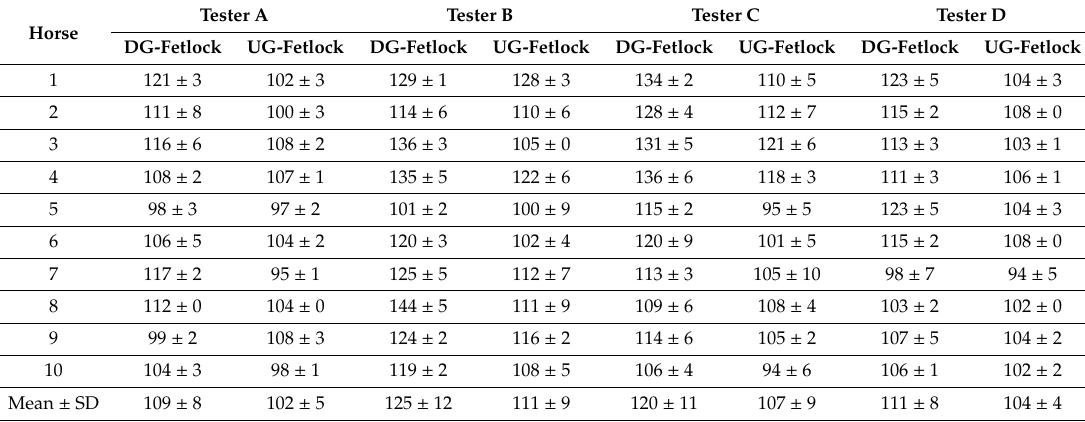
Table 1. Joint angles of fetlock joint flexion, as performed on ten horses by four testers and with two types of goniometers. Values are presented as mean ± standard deviation, and in degrees. Tester A Tester B Tester C Tester D Horse